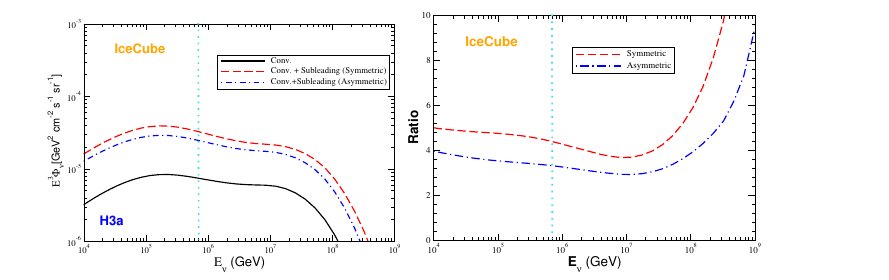
Figure 10. Our predictions for the flux of τ neutrinos (left panel) and the suggested enhancement factor with respect to the traditional c ¯ c → D s component (right panel).